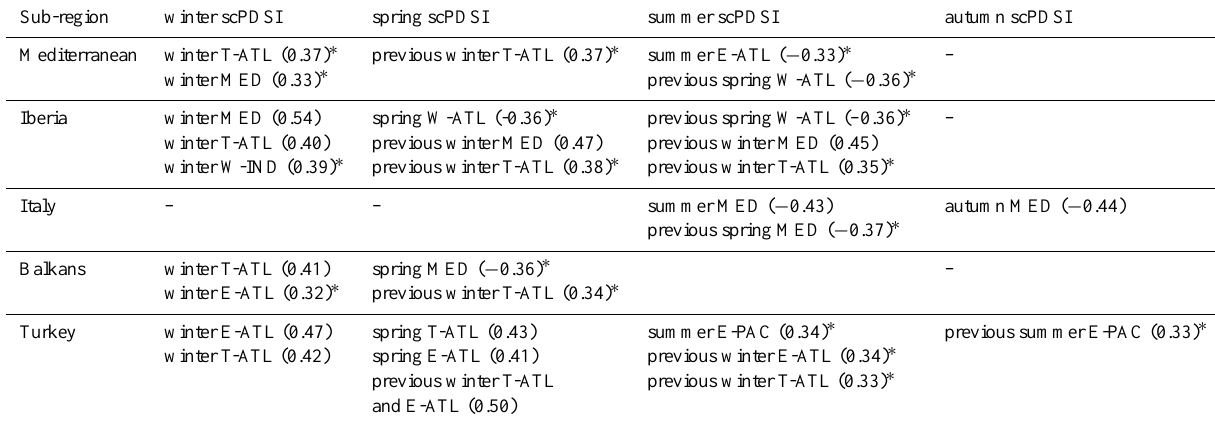
Table 5. Summary of the SST influence areas presenting significant correlation coefficient values (at the 5% level) with the seasonal scPDSI for each considered sub-region, for non-lagged, 3-month and 6-month lagged series. Values marked with ( ∗ ) only achieve the 10% level of statistical